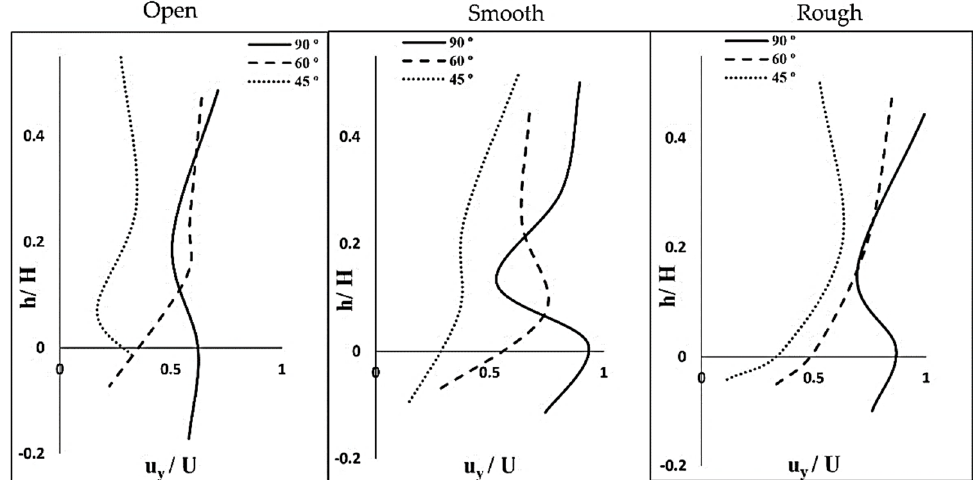
Figure 11. Lateral velocity profile (u y ) inside and outside the scour holes under different surface cover conditions for different dike orientations (water depth: 35 cm). ADV measurements subject to +/- 0.25 cm/s error.